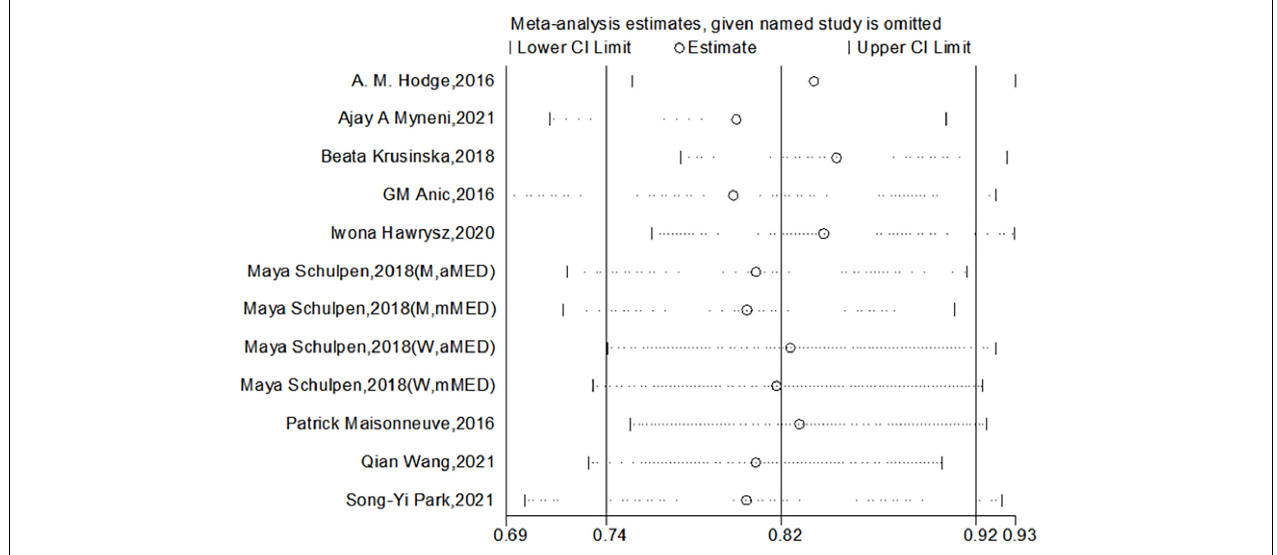
FIGURE 5 | Sensitivity analysis of the Mediterranean diet patterns and the risk of lung cancer.